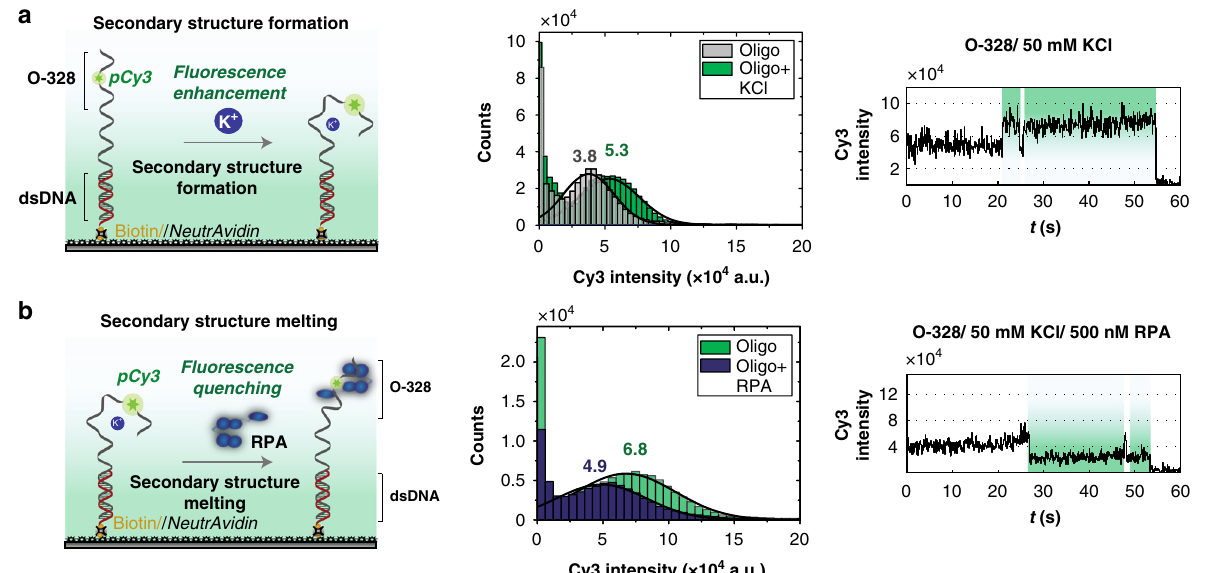
Fig. 6 DNA structural changes monitored using Cy3 fl uorescence modulation. a Secondary structure formation. Left: schematic showing the experimental set-up. Upon the addition of K + , a secondary structure is formed leading to an enhancement of Cy3 fl uorescence. Middle: Cy3 fl uorescence intensity histograms with (green) K + . The histograms are fi tted to Gaussian distributions. Right: representative single-molecule trace showing the transitions to the enhanced- fl uorescence state, upon formation of the secondary structure, as a result of the binding of K + . b Melting of the secondary structure. Left: schematic drawing showing the DNA construct used in c with a secondary structure formed in the presence of K + . However, upon addition of RPA, this secondary structure is melted, leading to the quenching of Cy3 ′ s fl uorescence. Middle: Intensity histograms of the Cy3 fl uorescence, in the absence (green) and presence (blue) of RPA. Histograms are fi tted with Gaussian distributions. Right: representative single-molecule trace showing the transitions to the quenched- fl uorescence state, upon melting of the secondary structure induced by the binding of RPA measurements for a and b were recorded